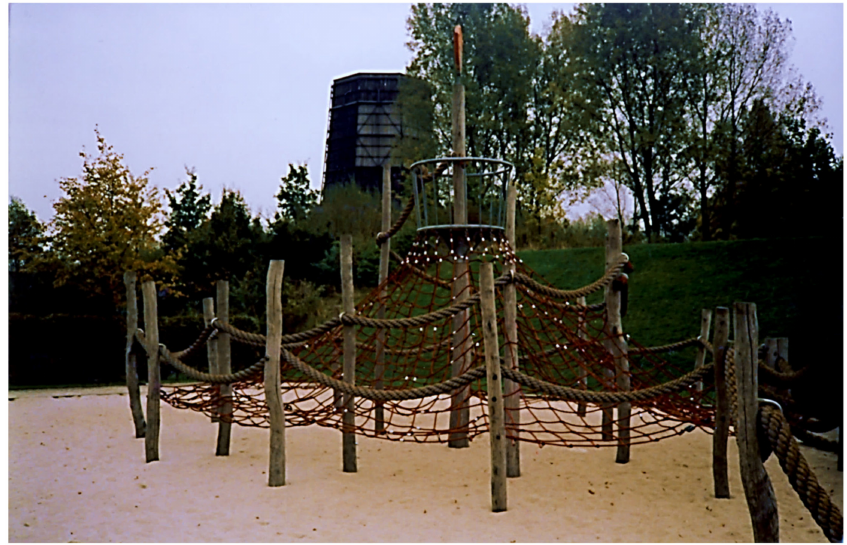
Figure 10. Green areas, relaxation areas against the background of the still old wooden cooling tower in Nordsternpark Gelsenkirchen. Source: photo by the